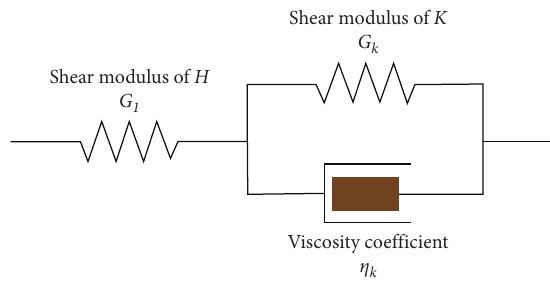
Figure 1: The Boltzmann viscoelastic